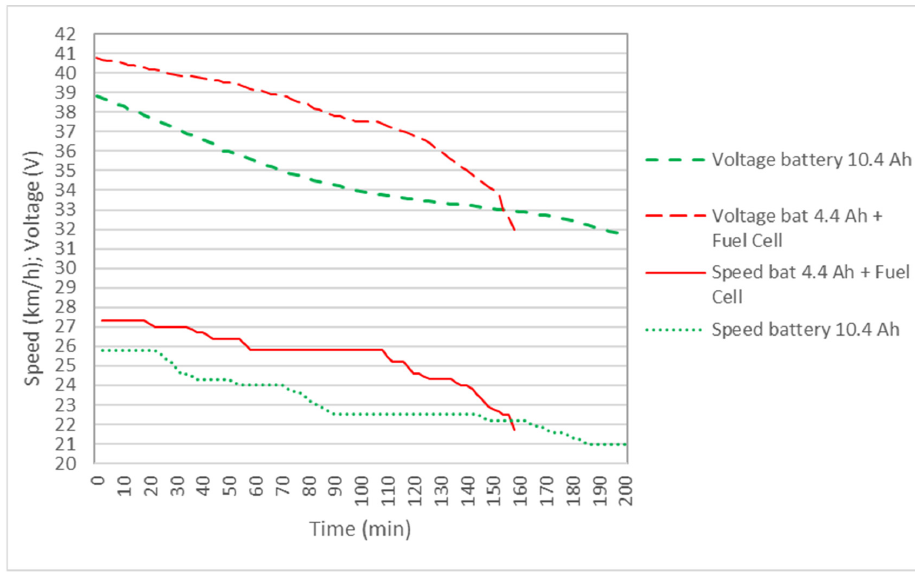
Figure 8. Comparison of motor voltage and bicycle speed for the 10.4 Ah battery and the 4.4 Ah battery + fuel-cell hybrid system in the case of two reactors.